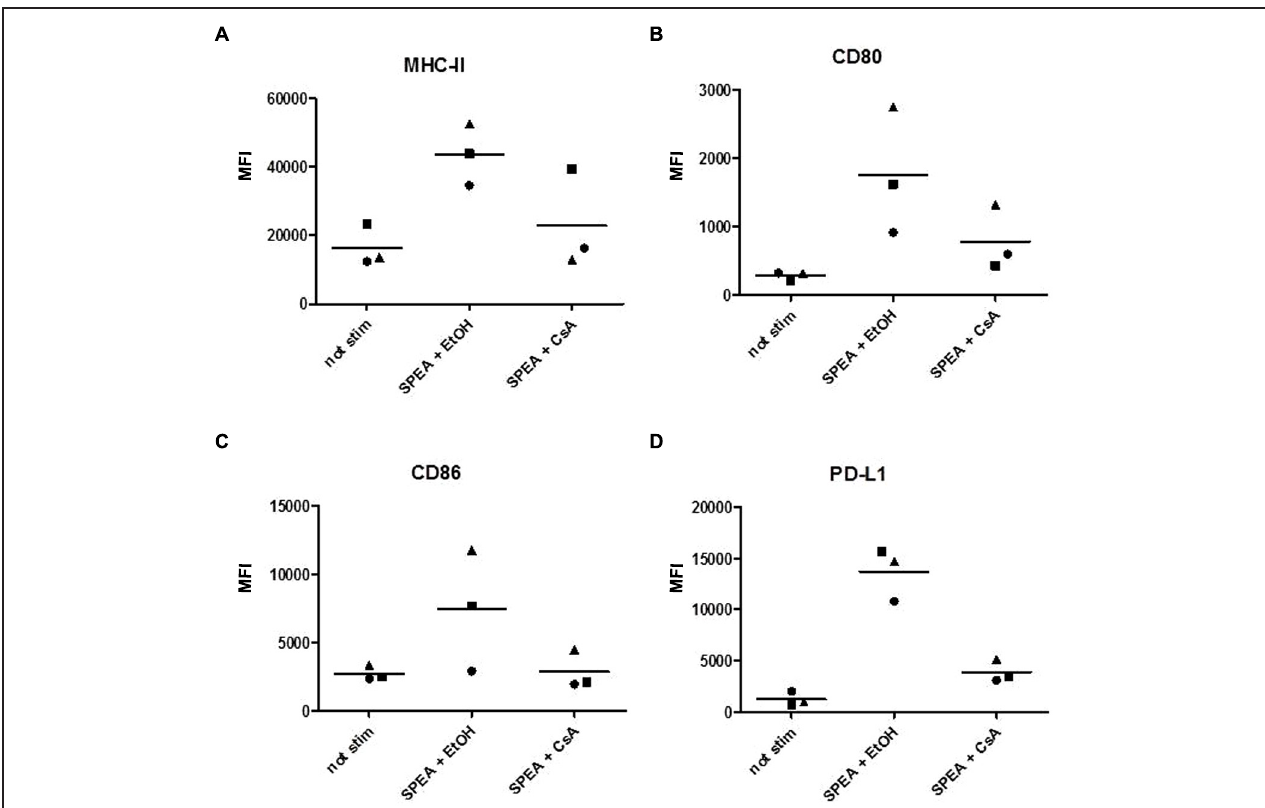
FIGURE 6 | Cyclosporine A prevents the expression of costimulatory and coinhibitory molecules. CD14 + monocytes were stimulated with SPEA (100 ng/ml) and CsA (1 μ M) or Ethanol (equal volume to CsA) for 24 h. Cells were harvested and analyzed for surface markers by flow cytometry (A) MHC-II, (B) CD80, (C) CD86 and (D) PD-L1. The mean fluorescence intensity of three different donors is